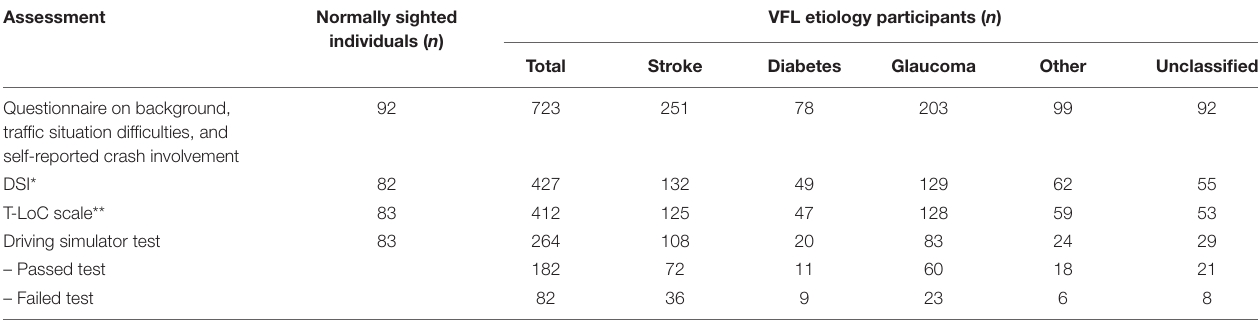
TABLE 1 | Numbers of participants in each VFL etiology group who completed each